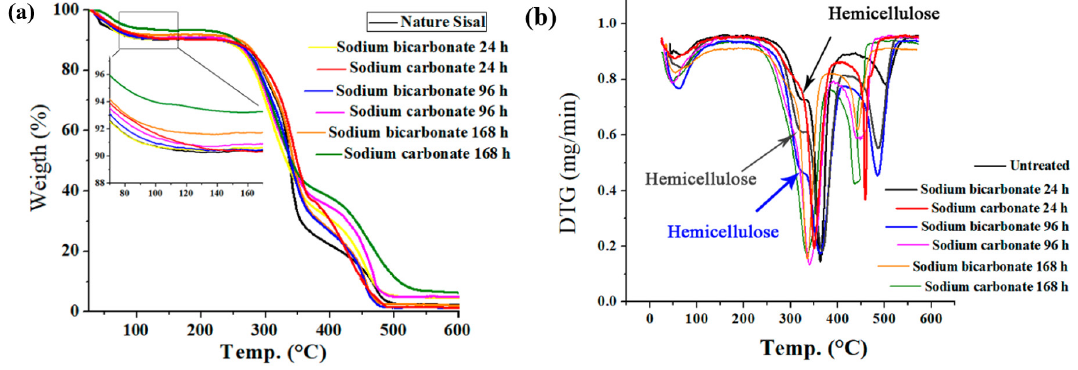
CO and NaHCO (24, 96 and 18 2 3 3